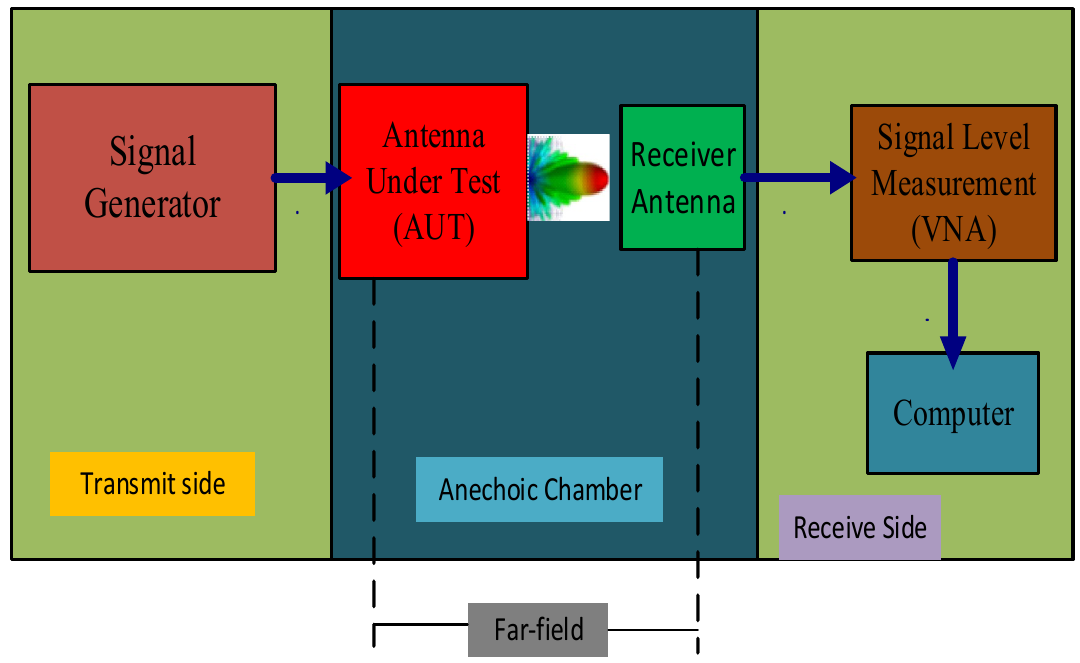
Figure 16. Schematic of experimental set-up.